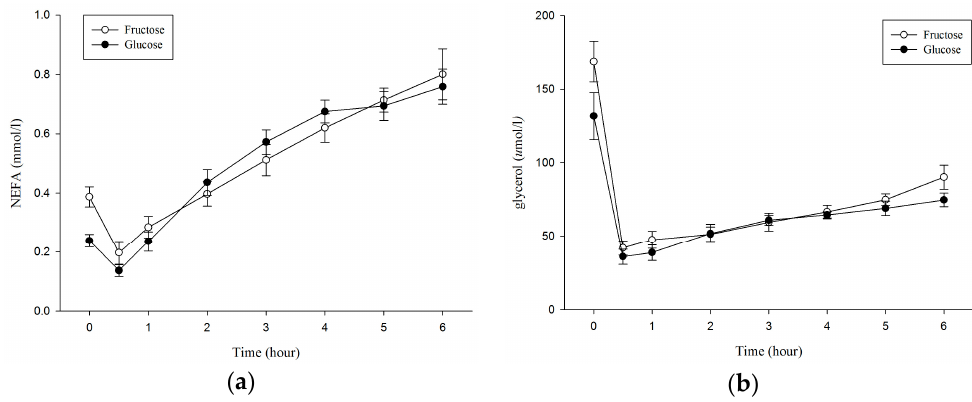
Figure 3. Plasma NEFA concentrations ( a ); and glycerol concentrations ( b ) during the 6 h postprandial period. NEFA: non-esterfied fatty acid.